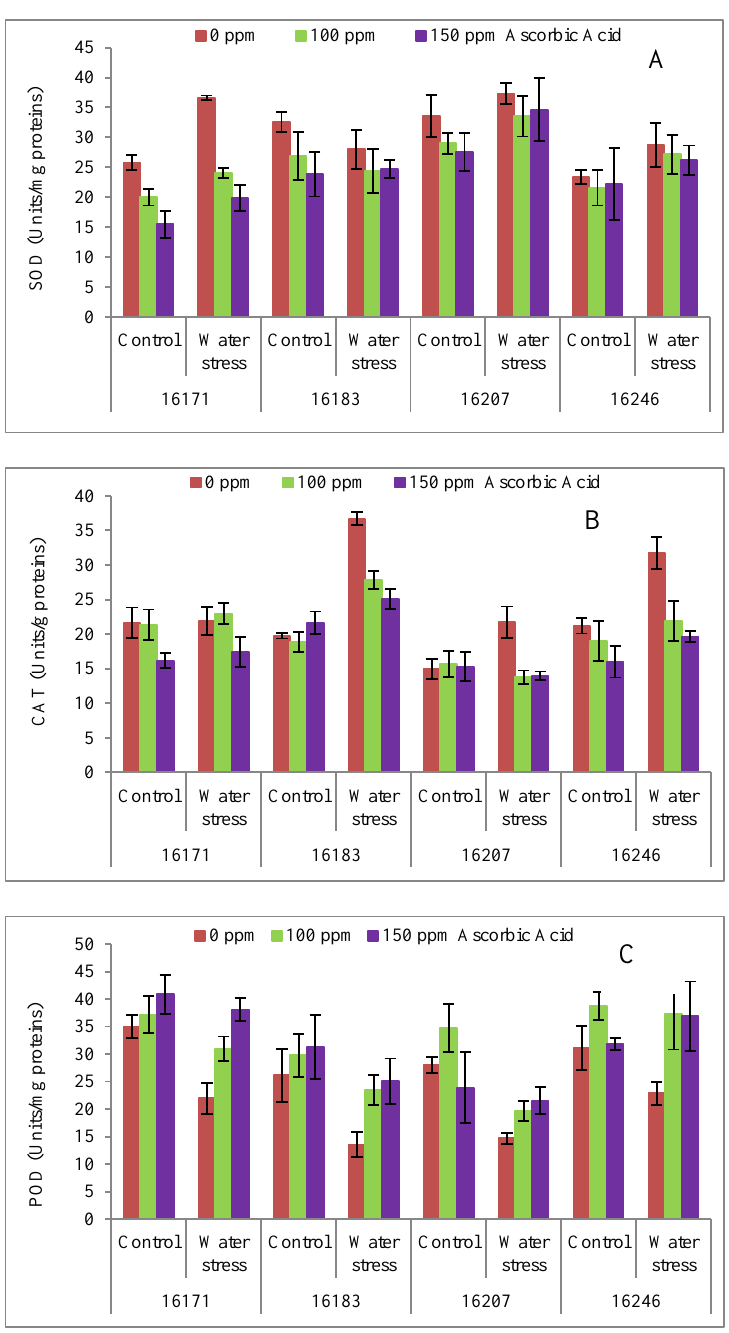
Figure 5. Activities of superoxide dismutase (SOD) ( A ), catalase (CAT) ( B ) and peroxidase (POD) ( C ) enzymes of four cultivars of safflower ( Carthamus tinctorius L.) foliarly treated with ascorbic acid subjected to water stress conditions (mean ± S.E.).